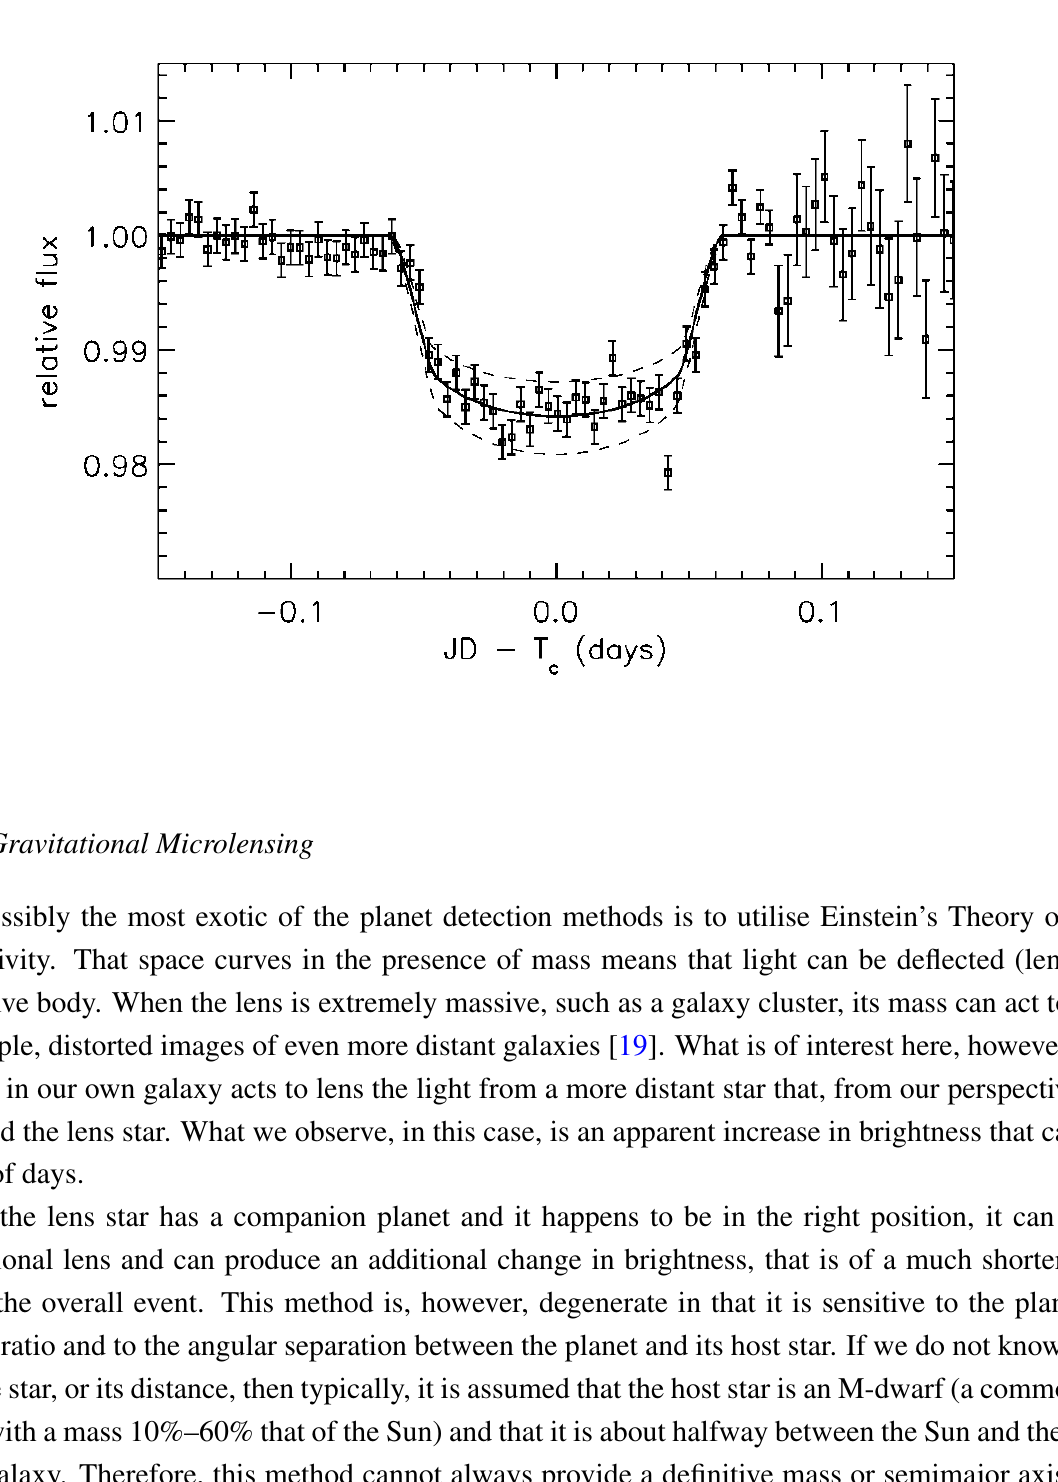
Figure 2. The light curve of HD209458, which shows a small dip in brightness when its companion planet transits across the face of the star. This measurement can be used to infer the radius of the planet. (Figure from